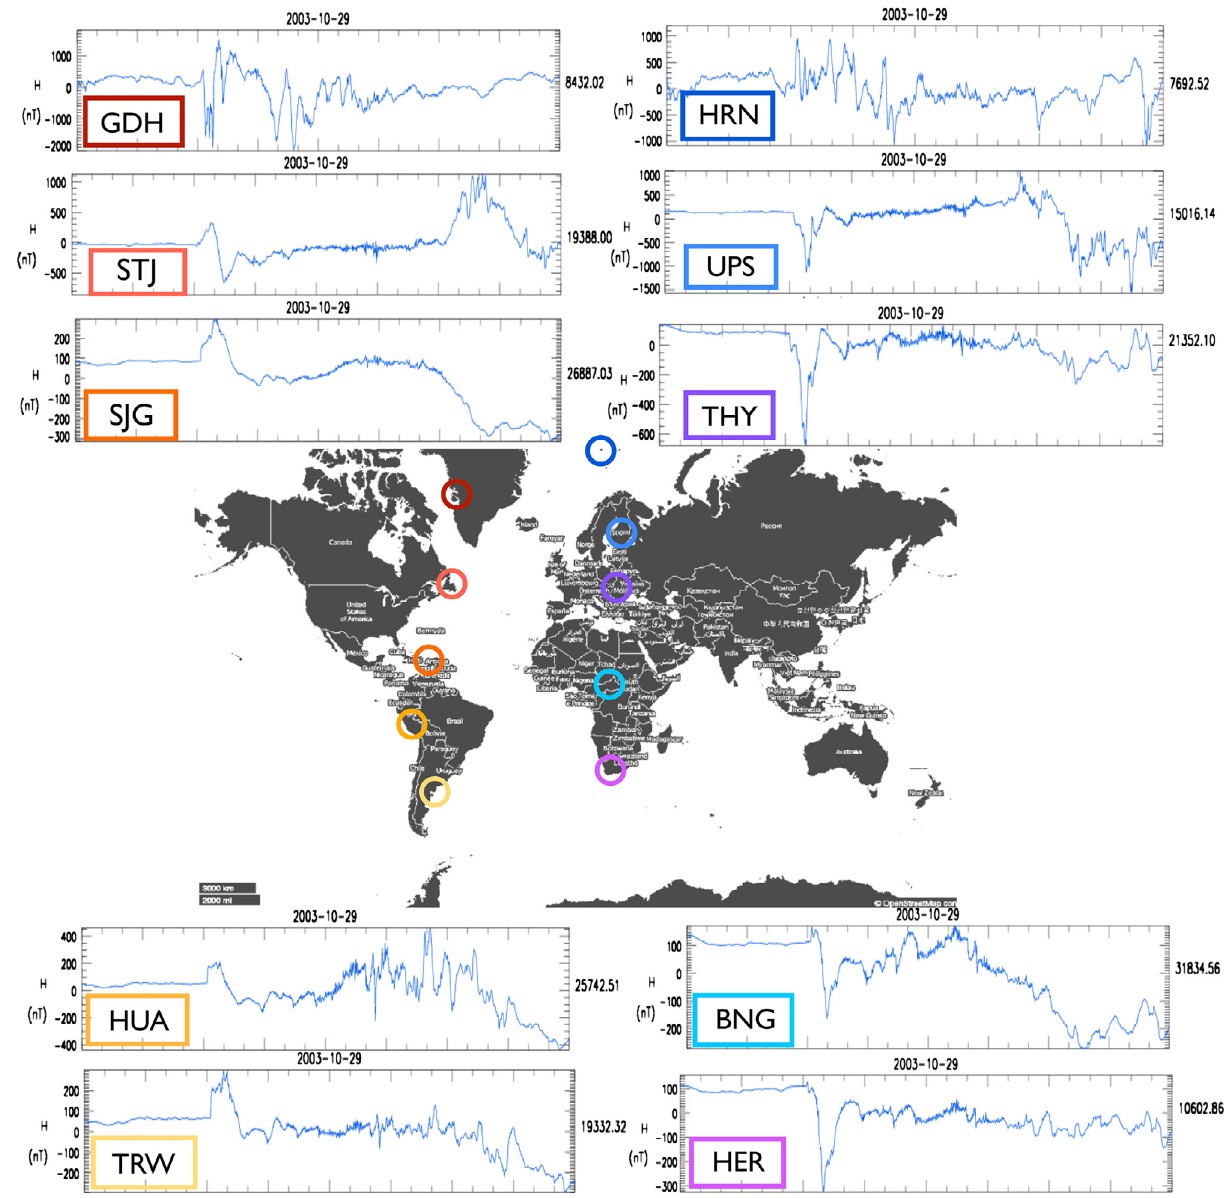
Fig. 3. Map showing H records along two main longitudes: 300 (cid:3) and 10 (cid:3) . The profiles of the H component are clearly different at different locations on 29 October 2003. Offset values are shown at the right of each panel.